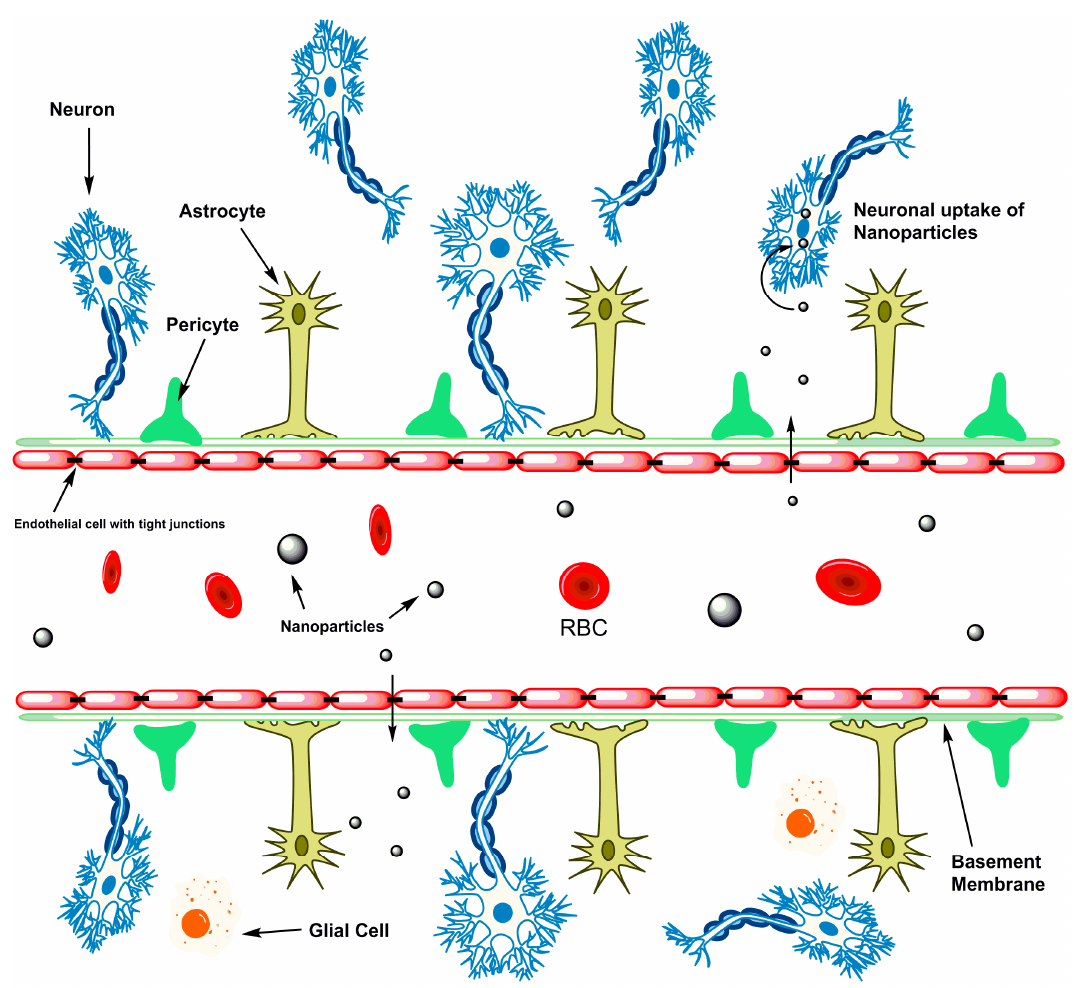
Figure 3. NPs are able to cross the restrictive blood brain barrier to be taken up by neurons and prevent further neurodegeneration.